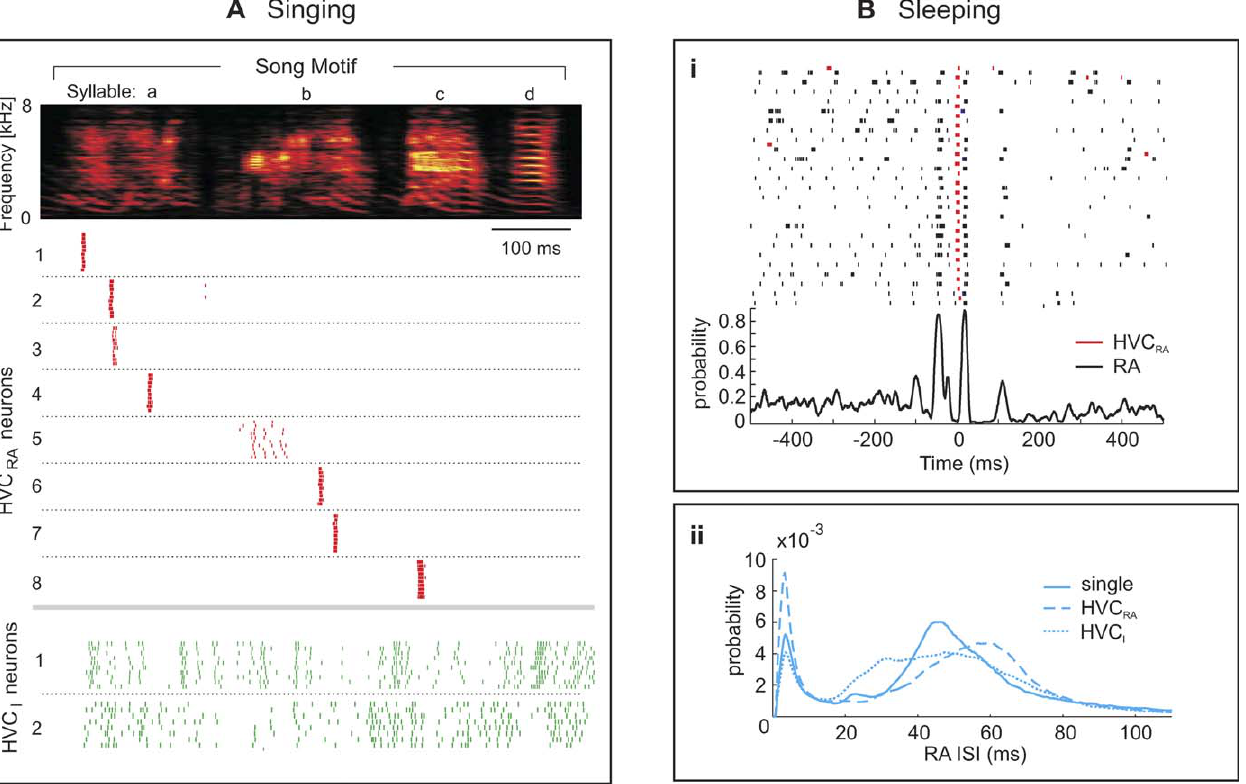
Figure 1. Song and Sleep-Related Firing in HVC and RA Neurons of Zebra Finches (A) During the production of a song motif (sound spectrogram on top), RA-projecting HVC neurons (HVC RA neurons) produce at most one stereotyped spike burst (red rasters). HVC interneurons (HVC I neurons) produce dense and less-stereotyped spike patterns (green rasters). A more elaborate version of this figure was originally published in [1]. (B) Sleep-related firing in HVC RA and RA neurons. (i) Top: spike-raster plot of a simultaneously recorded HVC RA –RA pair during sleep. RA spikes (black rasters) have been time aligned to HVC RA bursts (red rasters). (i) Bottom: CSP function of the same neuron pair. Also known as the cross-intensity function, the CSP function is an estimate of the conditional RA spiking probability as a function of the time lag to HVC RA spikes (see Methods). (ii) ISI pdfs of RA neurons vary from one dataset to another. ISI pdfs have been averaged either over 29 RA neurons recorded in isolation (full line), or over 26 RA neurons recorded simultaneously with HVC RA neurons (dashed line), or over 50 RA neurons recorded simultaneously with HVC I neurons (dotted